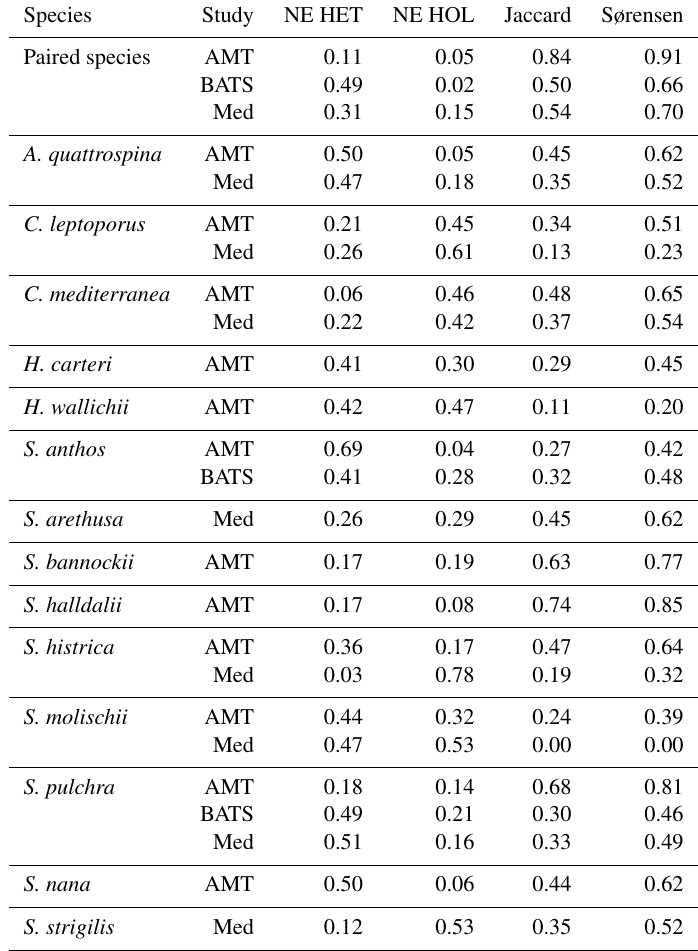
Table 8. Niche expansion (NE) and niche overlap.